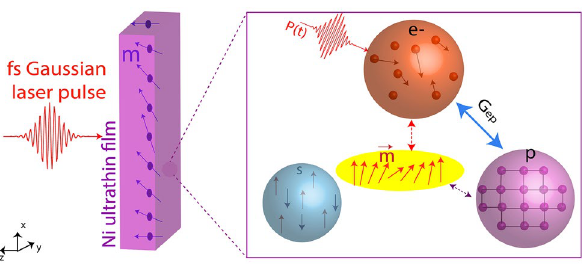
Figure 1. (Left) The schematic of ultrashort (femtosecond) laser pulse interaction with the metallic magnetic ultrathin film. (Right) Coupled interaction between electron, phonon, and magnetization is shown. We investigate the energy transfer by employing extended microscopic three temperature